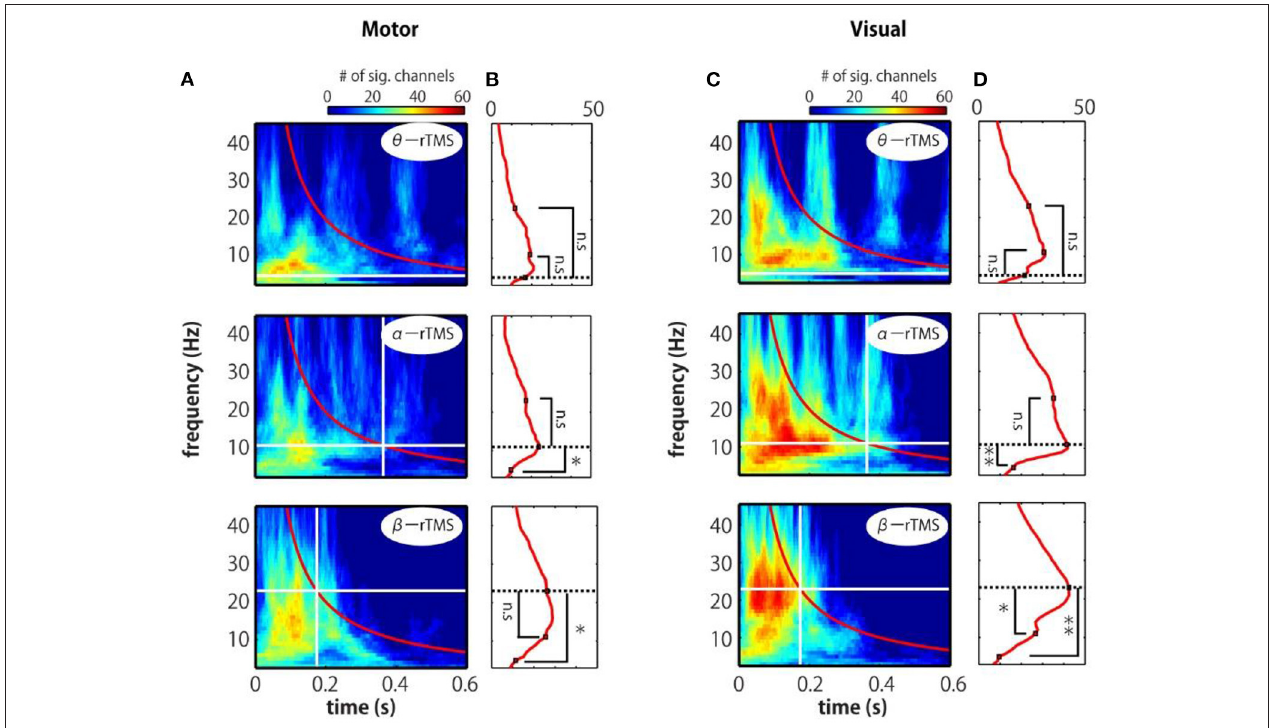
FIGURE 5 | Time-frequency representations of the number of significant electrodes. (A,C) Each map indicates the number of significant electrodes, determined by comparing the real and sham conditions. (B,D) Mean number of significant electrodes over four cycles at each frequency (red line in panels A and C ). The vertical and horizontal lines indicate the timing of the last pulse and the stimulation frequency. The number of significant electrodes was compared between the stimulation frequency and other frequencies (binomial test; * p < 0.005, ** p <